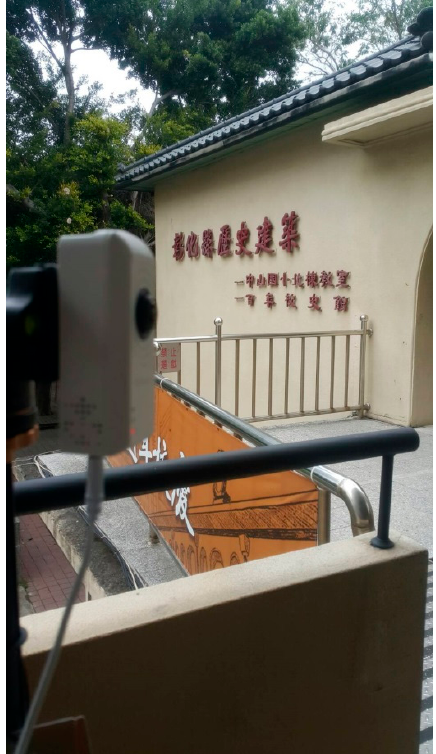
Figure 5. Cloud ‐ based surveillance system with wireless camera. Figure 5. Cloud-based surveillance system with wireless